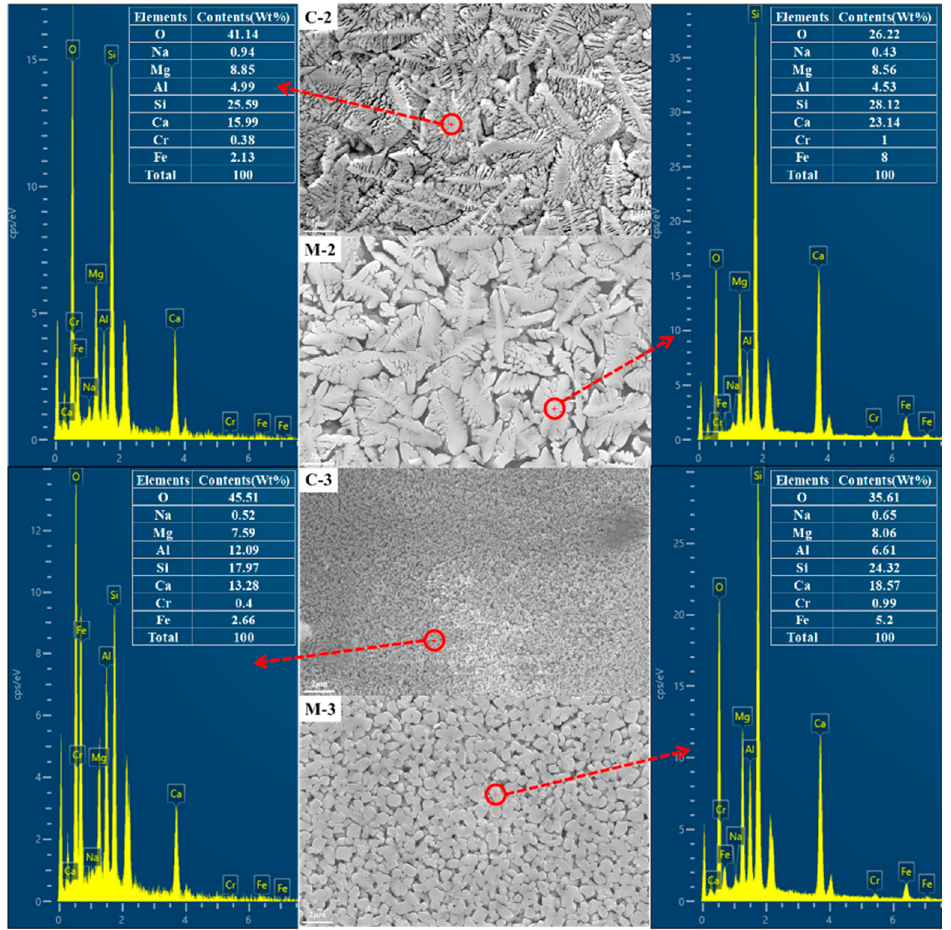
Figure 4. SEM image and EDS analysis of glass-ceramics produced by conventional (C-2, C-3) and microwave (M-2, M-3) heating.